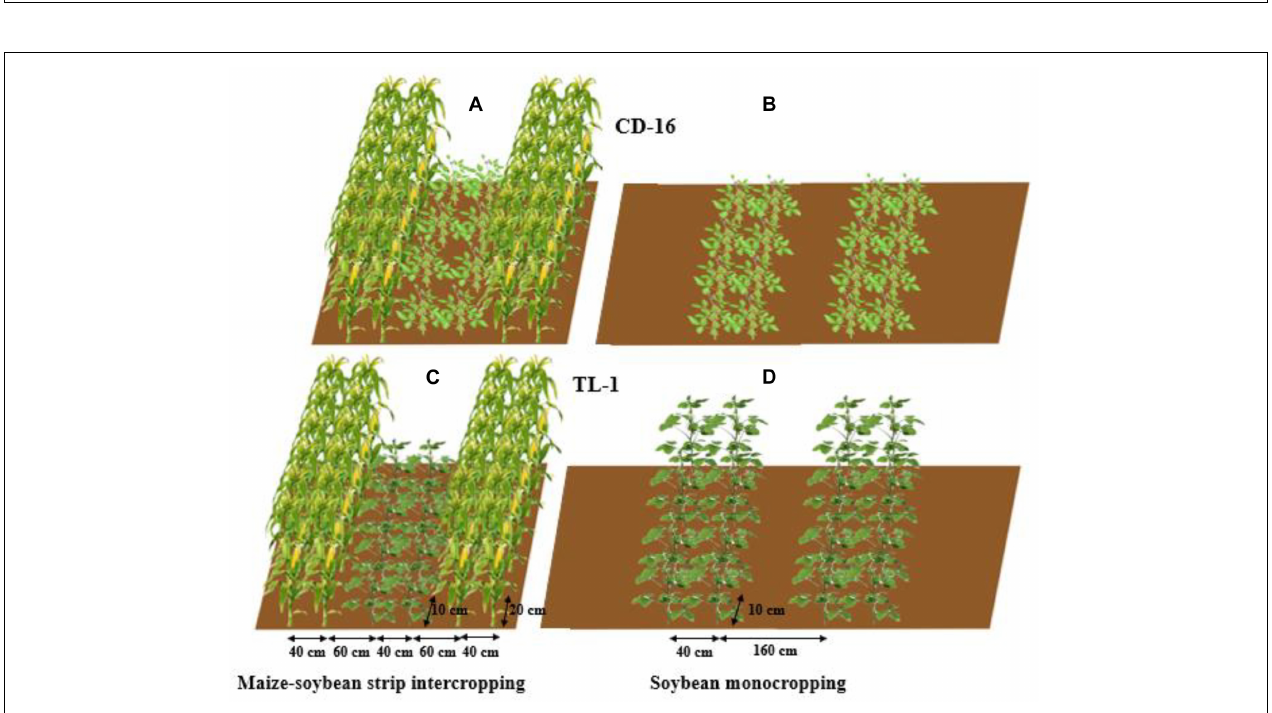
FIGURE 2 | The patterns of maize–soybean strip intercropping system (A,C) and monoculture (B,D) in 2020 and 2021. Regardless of Chuandou-16 (CD-16) (A,B) or Tianlong NO. 1 (TL-1) (C,D) , the soybean plant spacing is 10 cm and the row spacing is 40 cm. The maize plant spacing is 20 cm and the row spacing is 40 cm. In monoculture, the row spacing between each soybean strip is 160 cm.